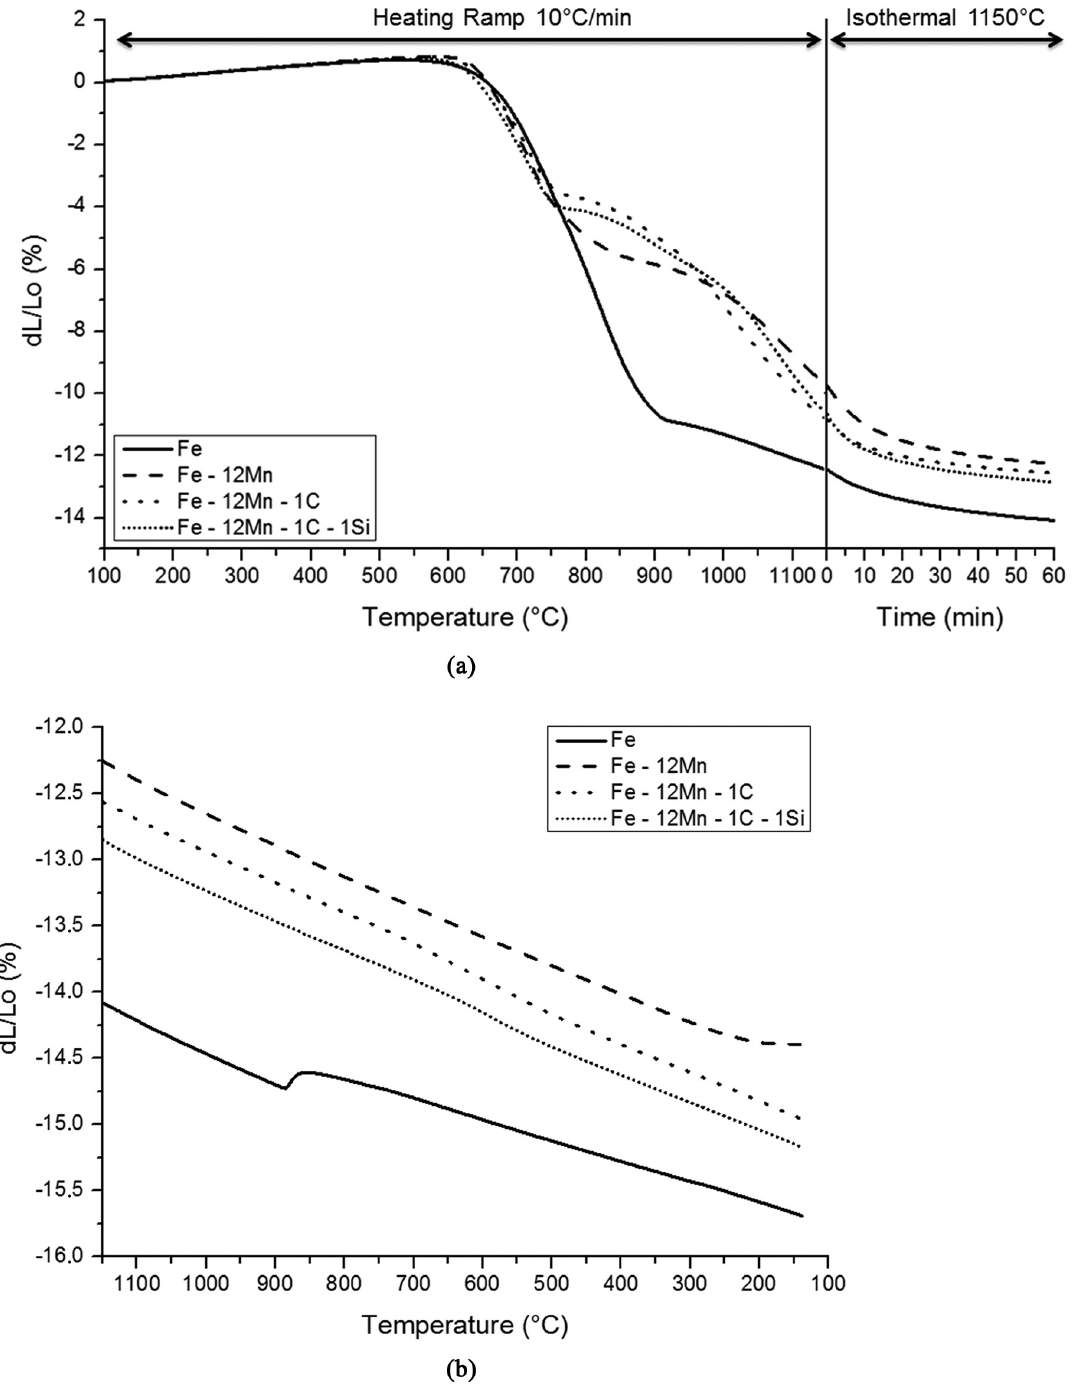
Figure 1. Dimensional changes during sintering of the materials presented in Table 1. (a) Heating and isothermal holding. (b) Cooling. Author: Renan